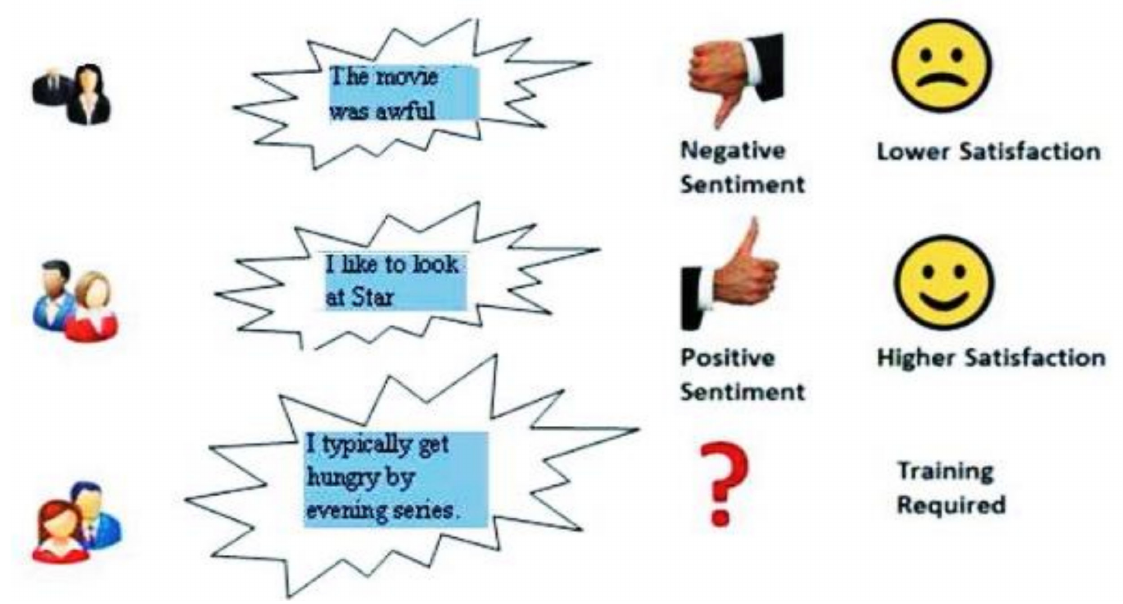
Figure 1. An example of emotional analysis results